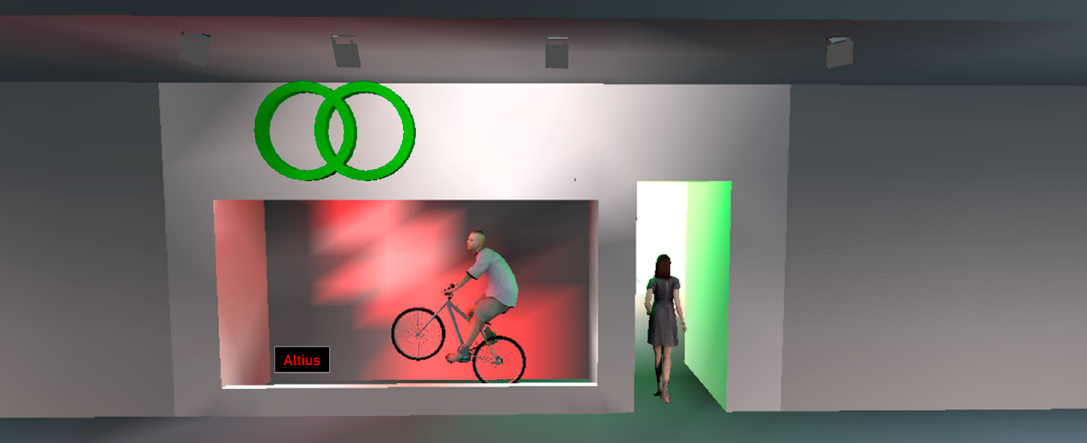
Figure 35. Fast communication at a glass case indicating the Olympic motto—Scene 1.